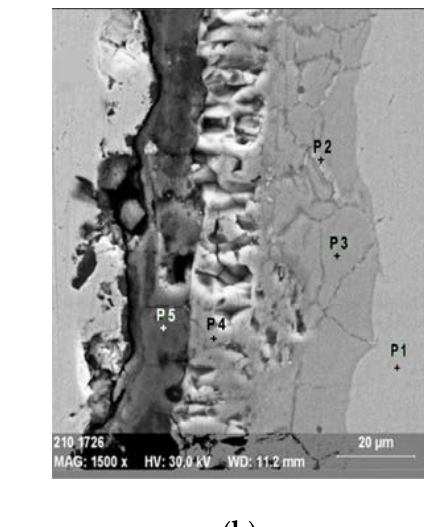
Figure 6. Cross-sectional SEM images for: ( a ) S1 sample; ( b ) S2 sample.